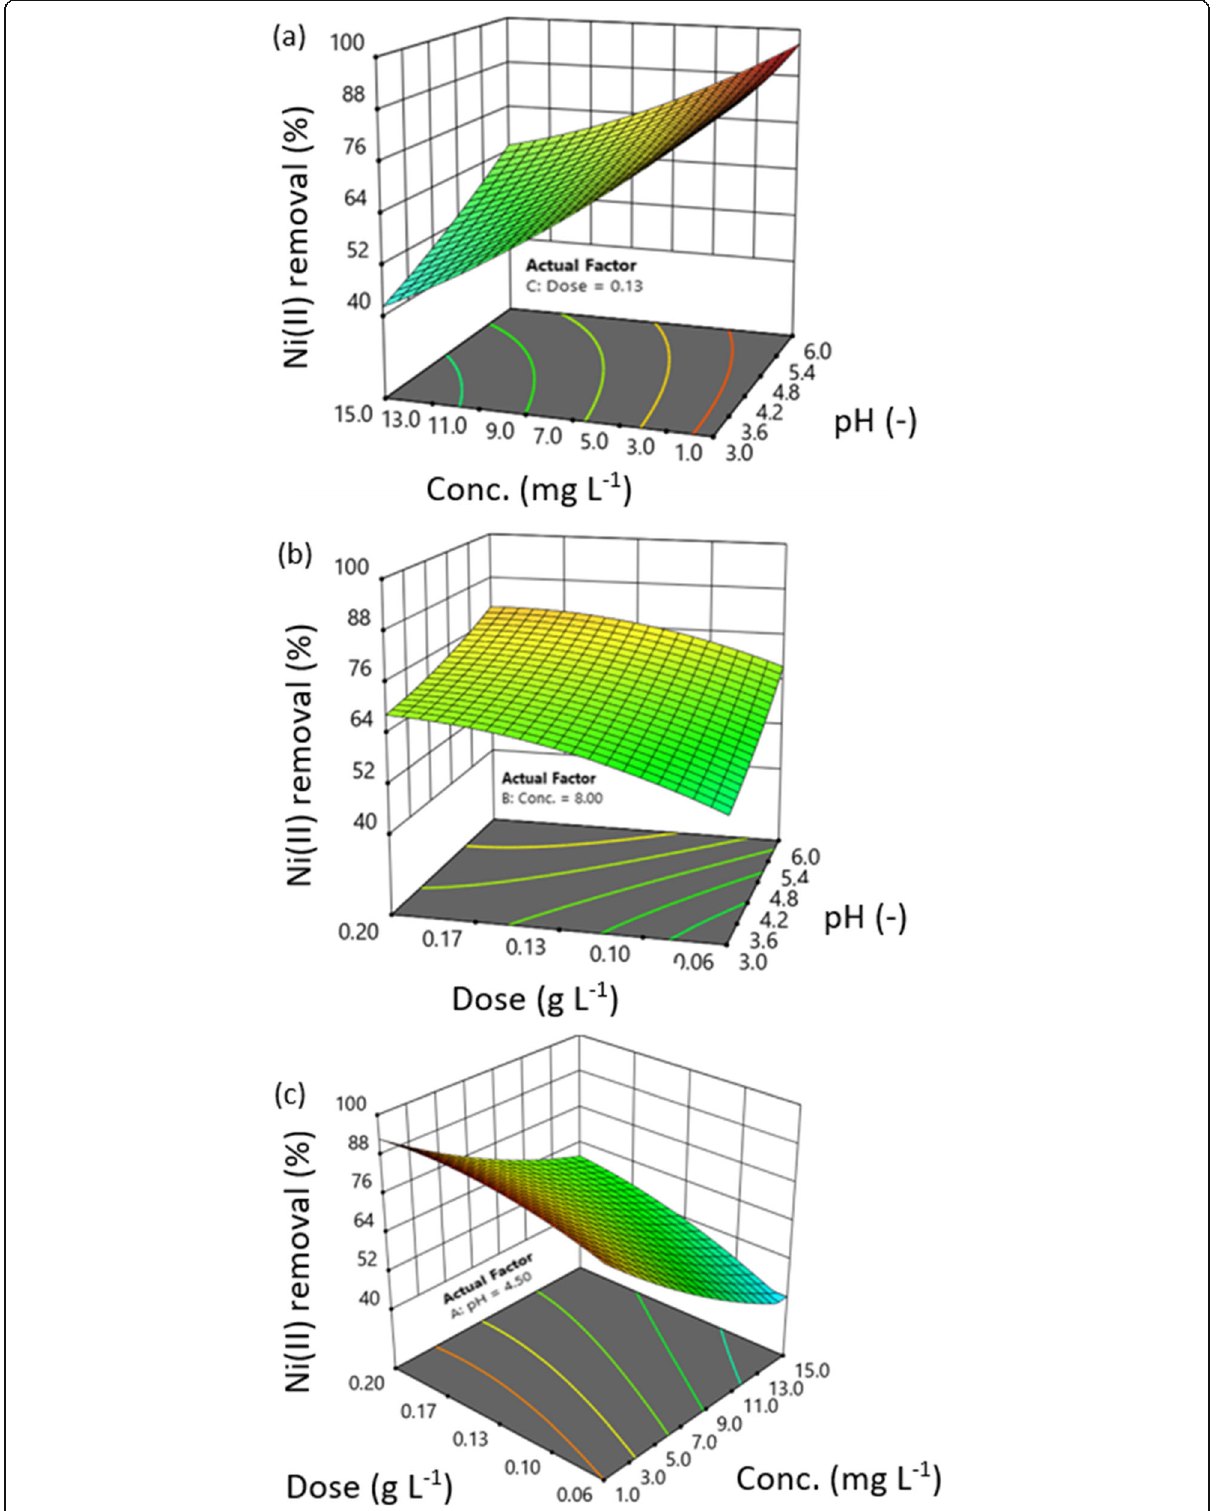
Fig. 6 3D response surface plots for Ni (II) removal using rGO with the interaction effects of ( a ) Ni (II) concentration (Conc.) x pH, ( b ) Dose x pH, and ( c ) Dose x Initial Ni (II) concentration